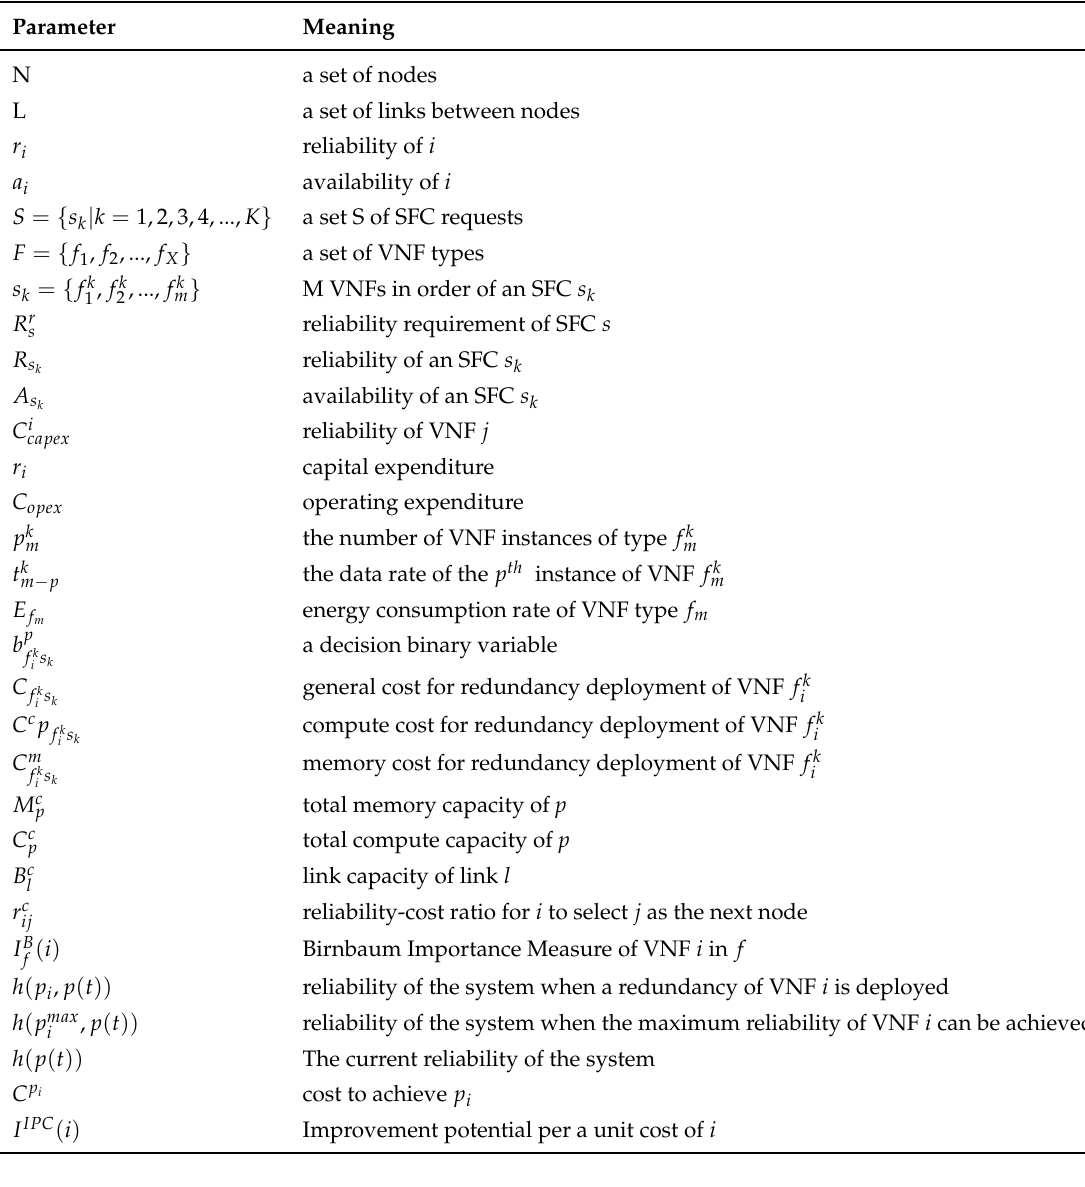
Table 1. Parameters and